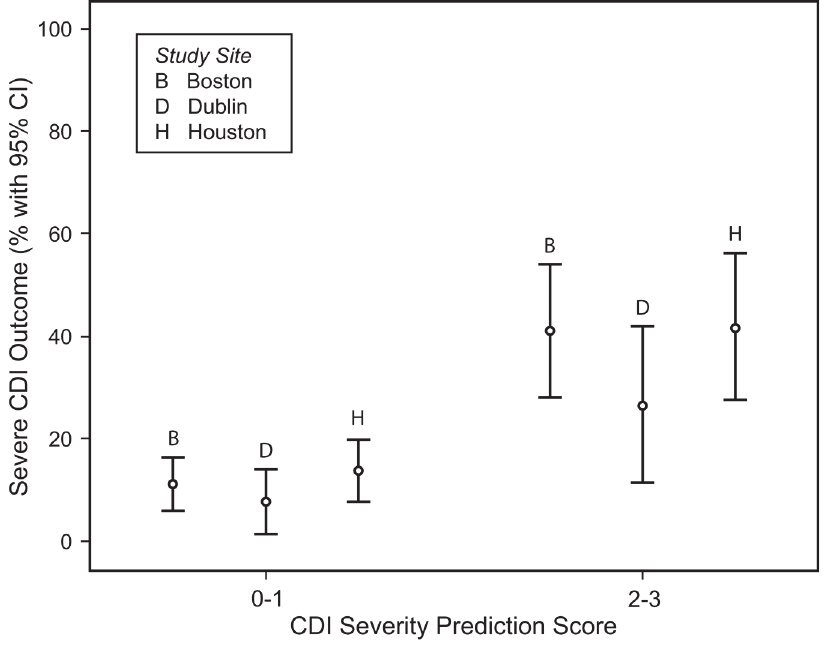
Fig 3. Association between CDI severity prediction score (0 – 1 or 2 – 3) and severe outcomes of CDI at each of the three study sites (B = Boston, D = Dublin, H = Houston).